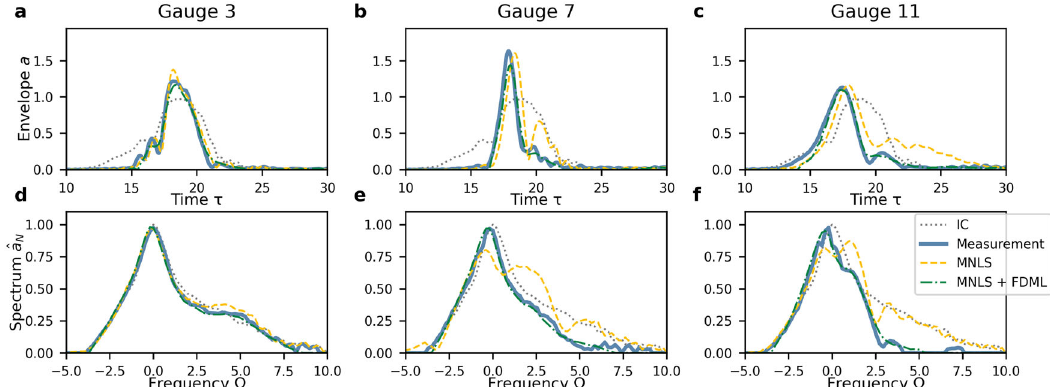
Fig. 4 Envelopes and amplitude spectra of the focused irregular waves (Wave Category II) at different wave gauge locations indicated by the red- dotted lines in Fig. 2. a – c Time-domain envelopes. d – f Amplitude spectra. a , d Gauge 3. b , e Gauge 7. b , e Gauge 11. Initial condition (IC, dotted gray), measurements (solid blue), MNLS simulations (dashed yellow), and MNLS + FDML simulations (dashed-dotted green).